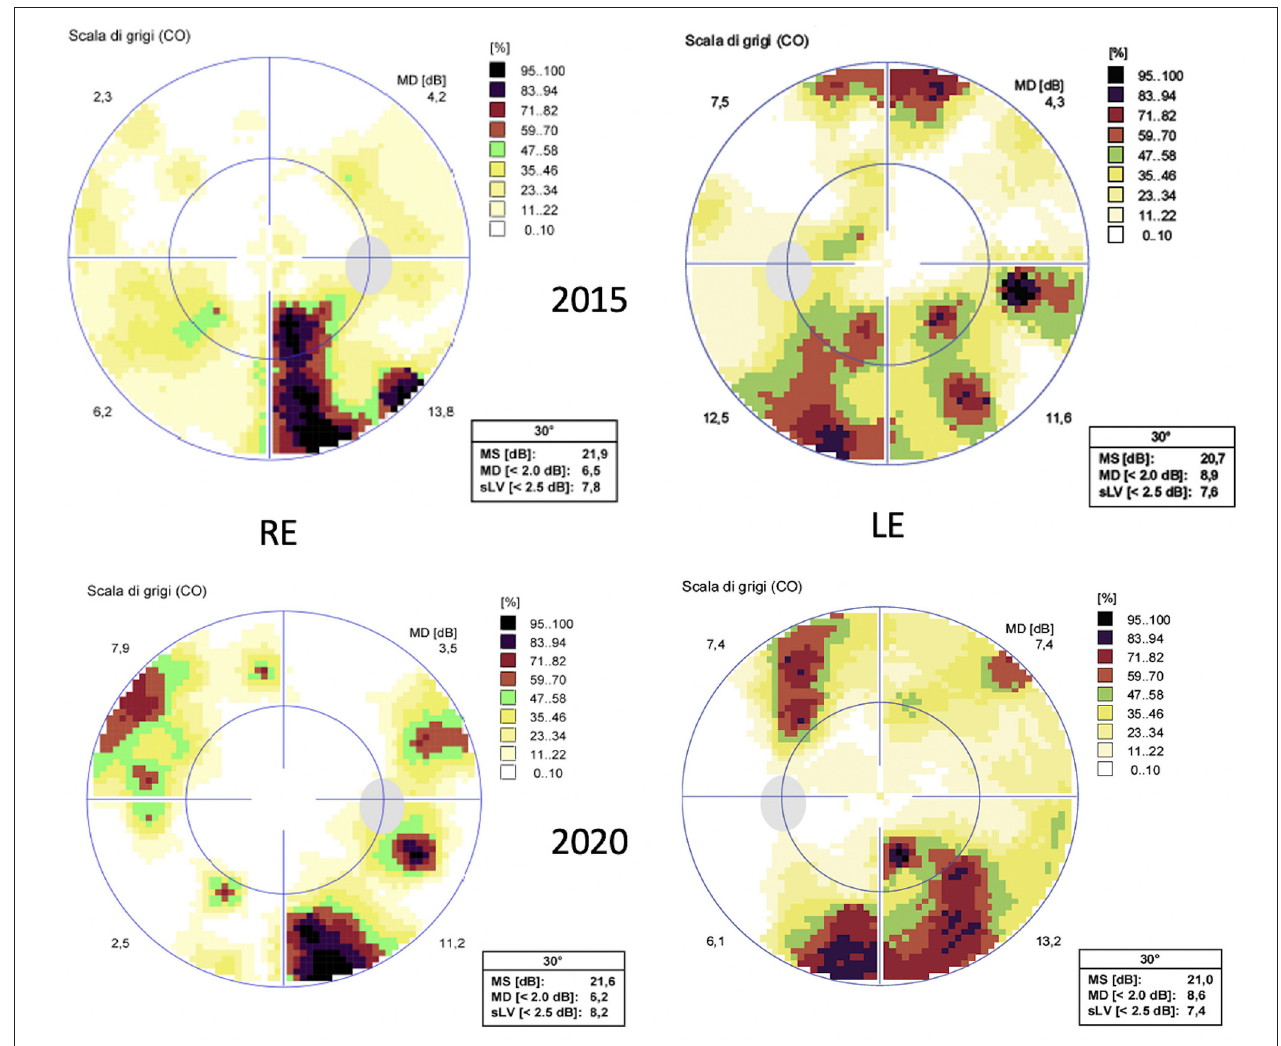
FIGURE 3 | Octopus visual field testing (32 standard). Above the exam performed in 2015 and below the exam performed in 2020, showing stable perimeter indices over the years.